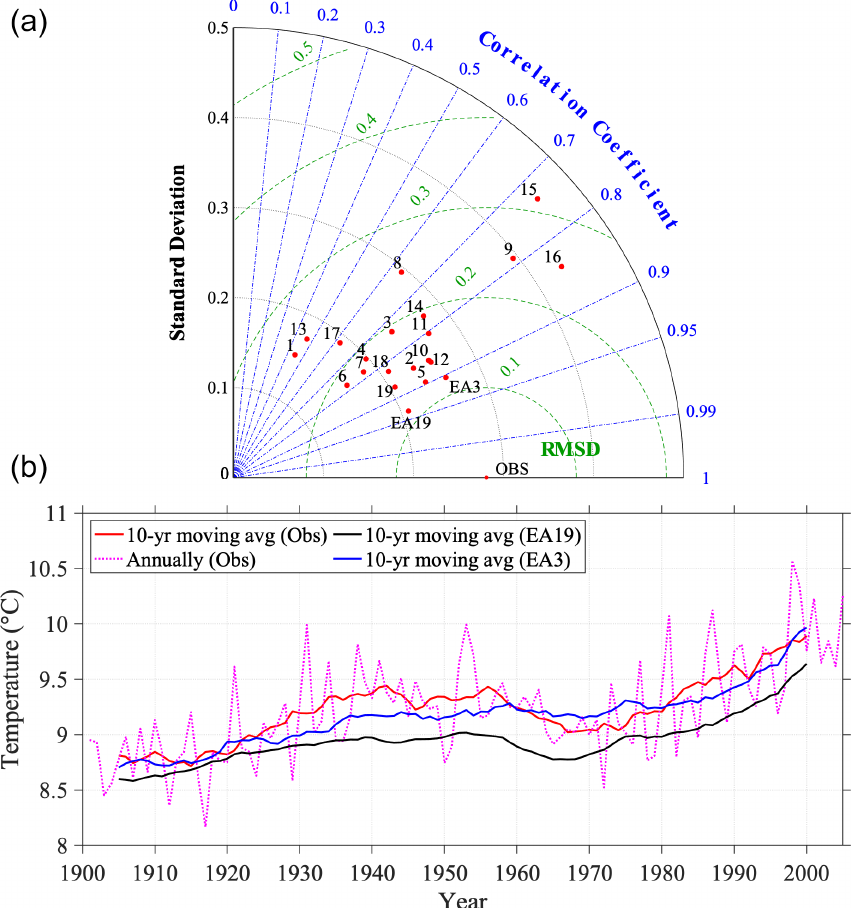
Figure 2. (a) Taylor diagram for 19 individual GCMs, ensemble average of 19 GCMs (EA19), and ensemble average (EA3) of the 3 selected GCMs (IPSL-CM5A-MR, MPI-ECM-MR, and GISS-E2-H) for the 10-year moving average of surface air temperature simulation for the period of 1901–2005 over the majority of North America. (b) Annual surface air temperature (pink) of CRU data, its 10-year moving average for the period of 1901–2005 for CRU (red) in comparison to the model results of EA3 (blue) and EA19